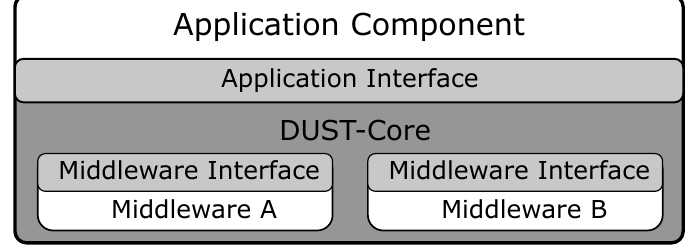
Figure 2. The common DUST-Core architecture.